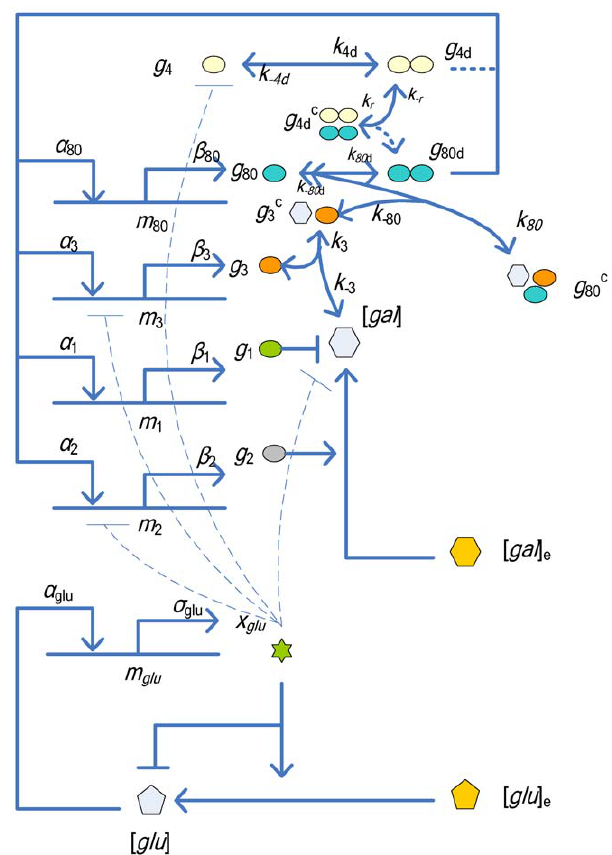
Figure 1. The gene regulatory network for galactose utilization (redrawn from Bennett etal. (2008) [ 12 ] ). The extracellular inputs are [ gal ] e and [ glu ] e . The natural output of the network is a group of proteins . The GAL 4 protein g 4 binds to upstream activation sites and activates the regulatory genes in the galactose network. The GAL 80 gene inhibits the inducing effects of GAL 4 and thereby provides negative feedback in the system. GAL 3 enhances expression of GAL 4 by binding with internal galactose (Gal), forming a GAL 3-galactose complex, g 3c , that inactivates g 80 by binding to it and resulting in a complex g 80c . In addition, the transporter GAL 2 increases the amount of internal galactose, which stimulates the galactose network. We use the GAL 1 mRNA level, m 1 , as the measureable output to control the system. According to sensitivity analysis, the interaction loops involving GAL4p dimerization (the dotted lines) can be eliminated from the original model to create a reduced model.